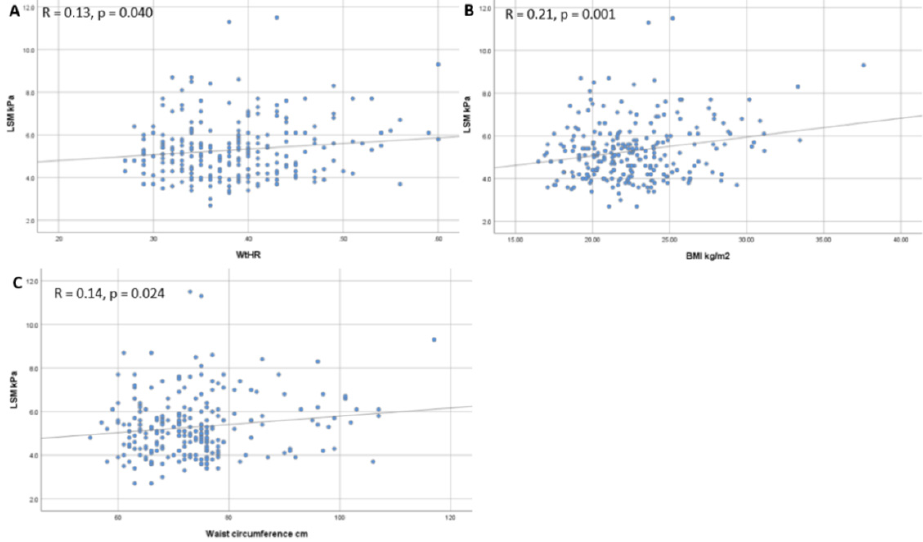
Figure 4. Correlation between LSM and WtHR (Figure 4A), BMI (Figure 4B), and Waist circumference (Figure 4C) .